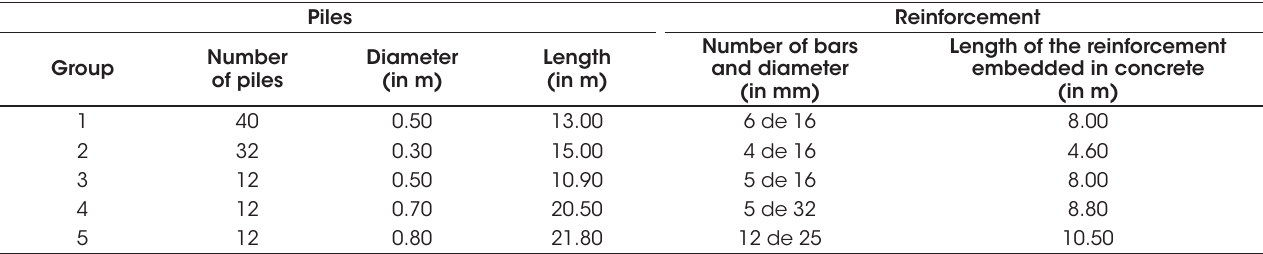
Summary of the piles